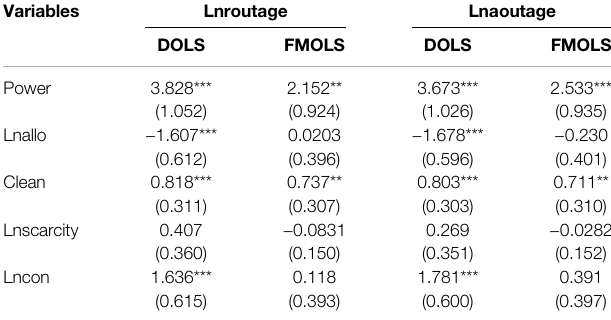
TABLE 7 | Robustness tests (under changing dependent variable) Variables